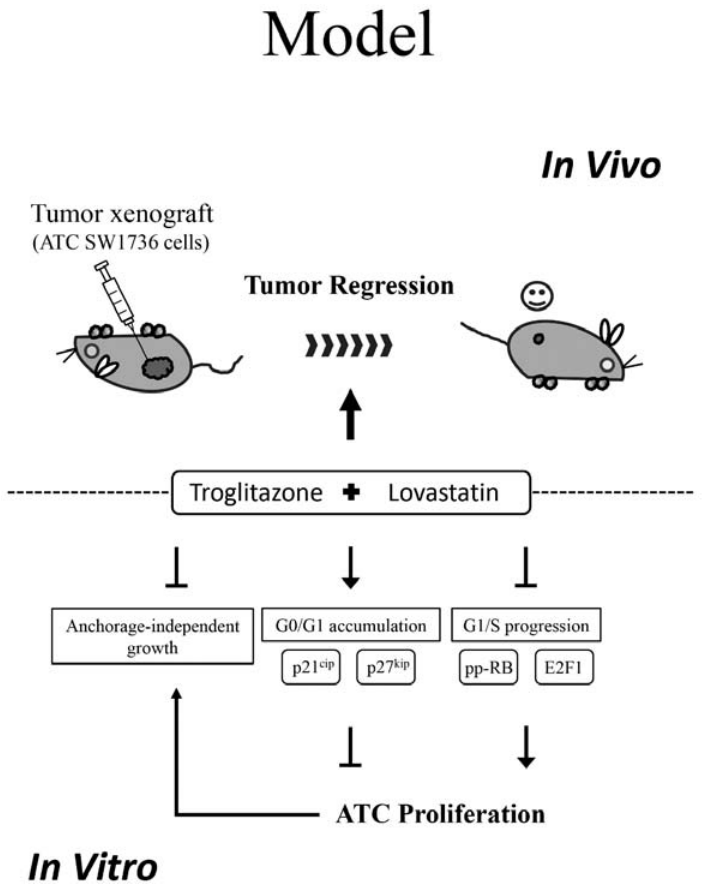
Figure 5. A working model for the anti ‐ tumor effects by combination of troglitazone and lovastatin. Combination treatment inhibits tumor growth and induces cell cycle arrest at the G0/G1 phase. The underlying mechanism is partly achieved through the upregulation of p21 cip and p27 kip , and partly through the reduction of pp ‐ RB and E2F1 expression. Arrow: promotion; T ‐ bar: inhibition.